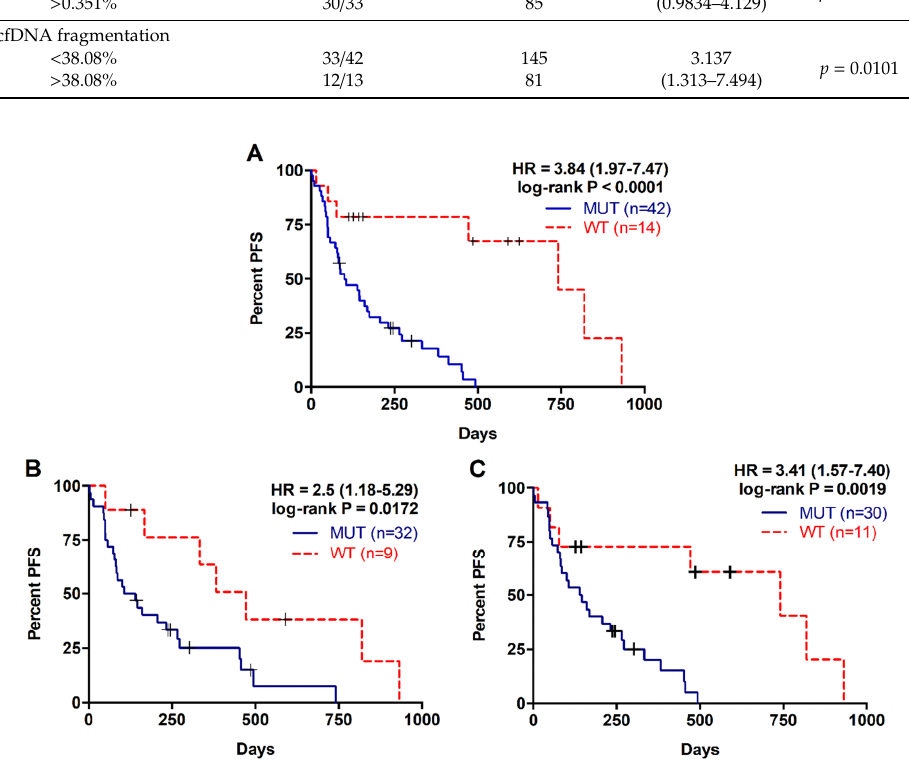
Figure 2. Progression free survival rates for patients with metastatic PDAC according to RAS mutation status. ( A ) PFS according to RAS mutation status in cfDNA; ( B ) PFS according to RAS mutation status in tissue; ( C ) PFS according to RAS mutation status in cfDNA of those patients with RAS mutations analyzed in tissue.